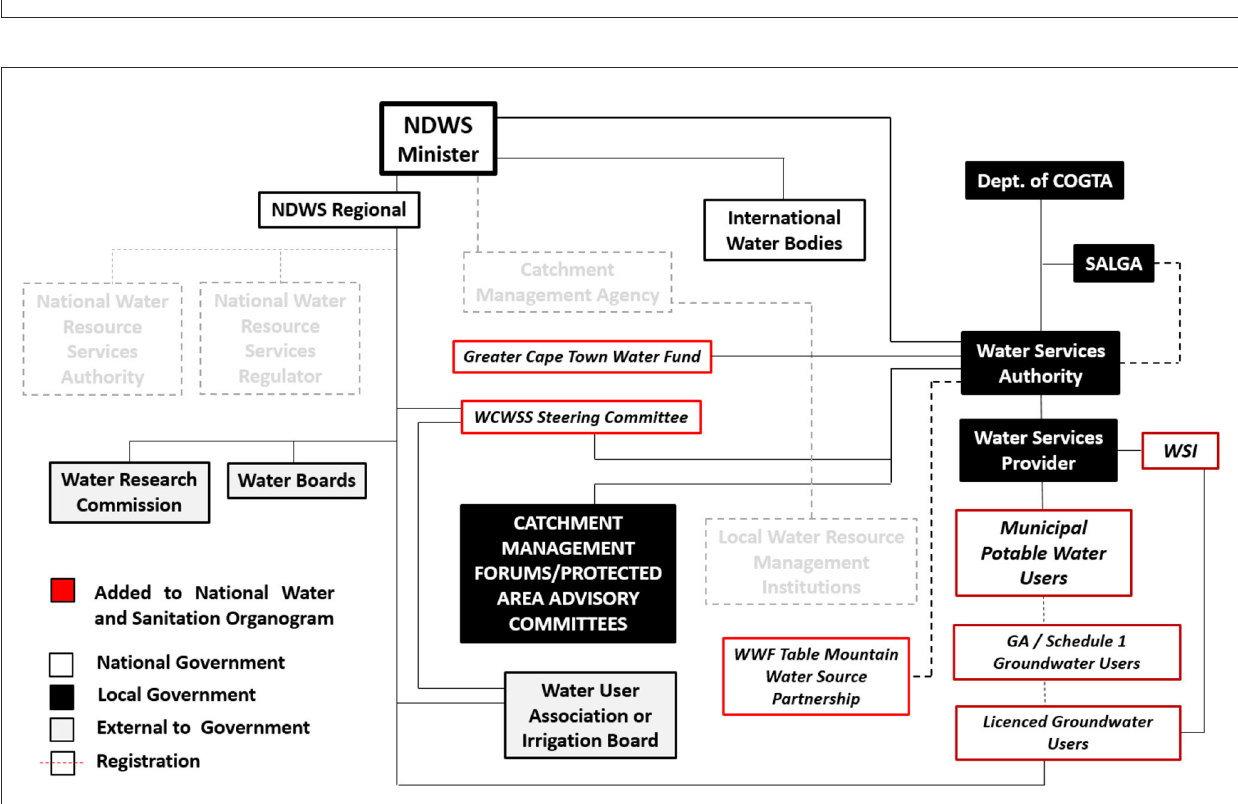
FrontiersinSustainableCities 09